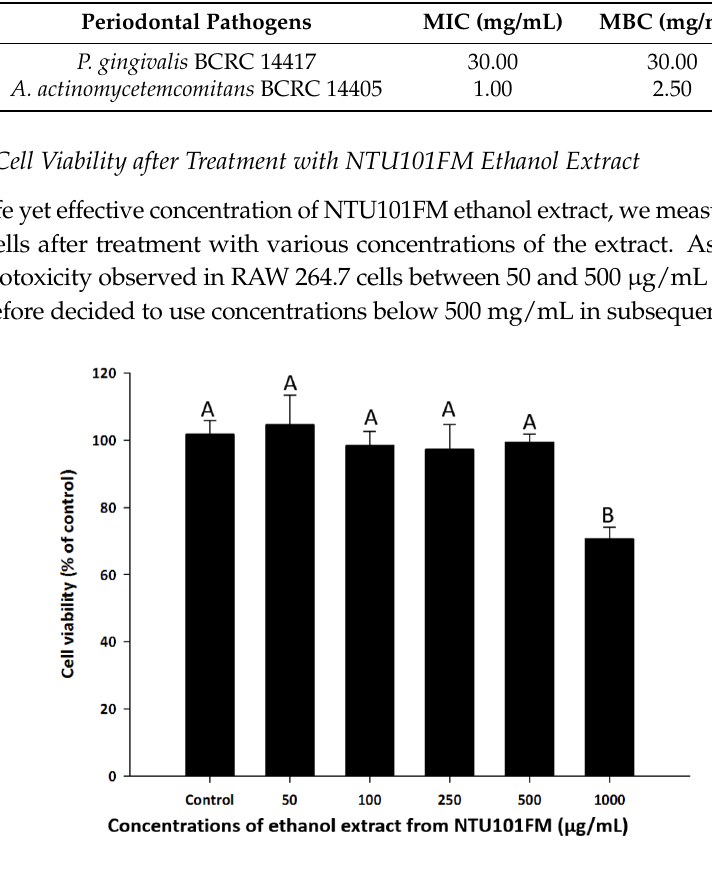
Figure 1. Effects of NTU101FM ethanol extract on cell viability of RAW 264.7 cell. Cells were treated with various concentrations of NTU101FM ethanol extract (50 to 1000 µ g/mL) for 24 h. Cell viability was measured by MTT assay and represented as percent of control cell viability. The data are presented as means ± SD ( n = 3). Values with different uppercase letters were significant by Duncan’s multiple range tests ( p <